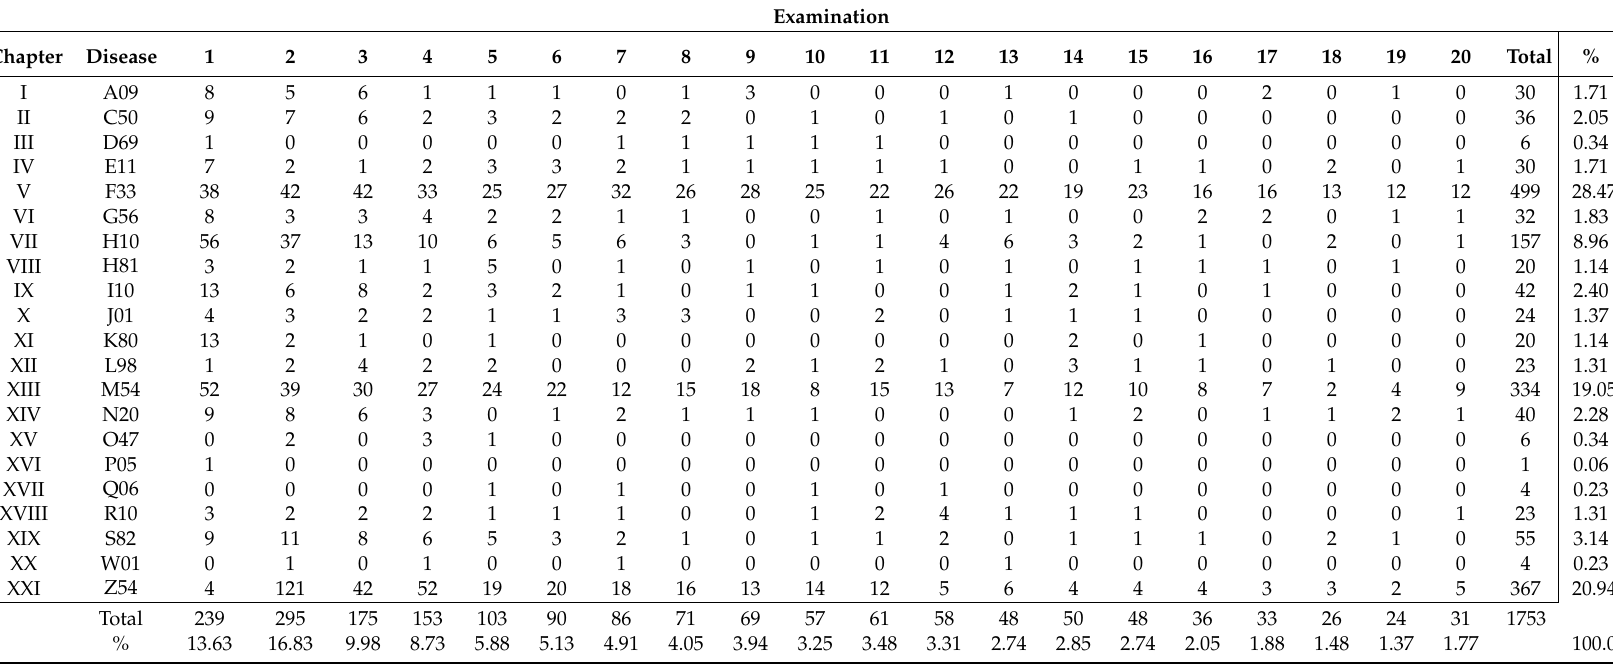
Table 1. Most prevalent diseases per ICD-10 chapter, in the first 20 medical examinations